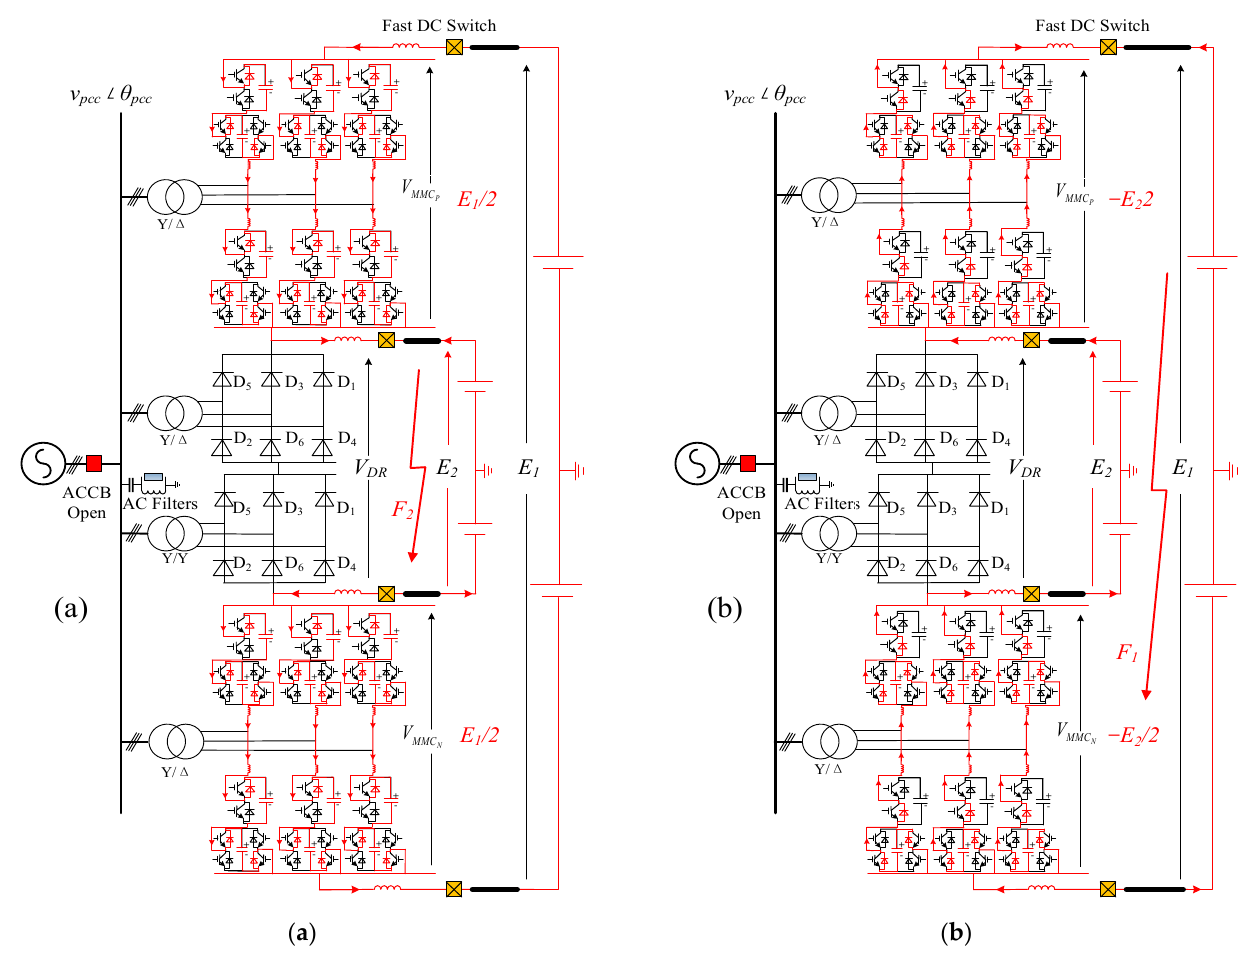
Figure 4. Fault current path of blocked MMCs during different DC faults: ( a ) current flow during F 2 fault; ( b ) current flow during F 1 fault.